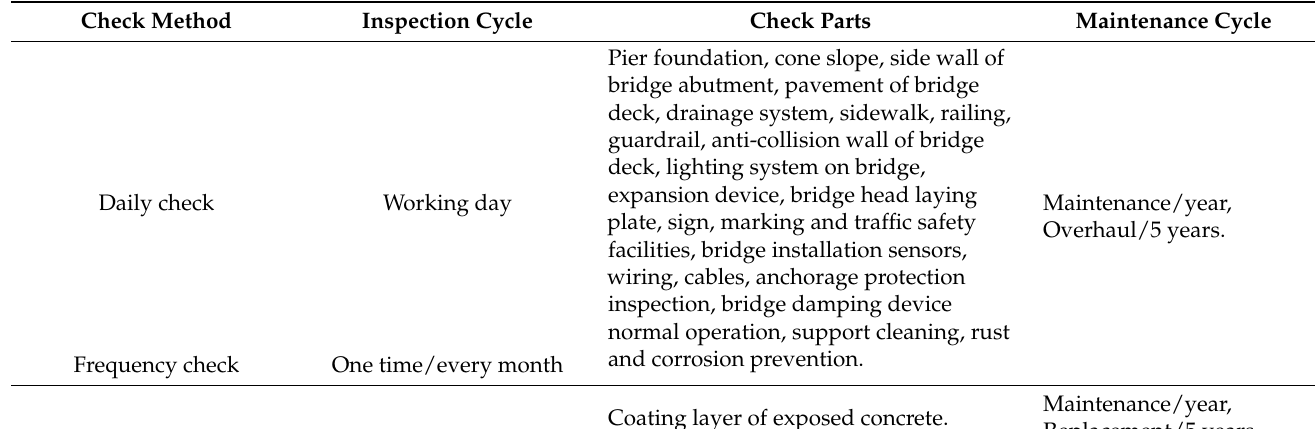
Table 2. Cable-stayed bridge maintenance data statistics